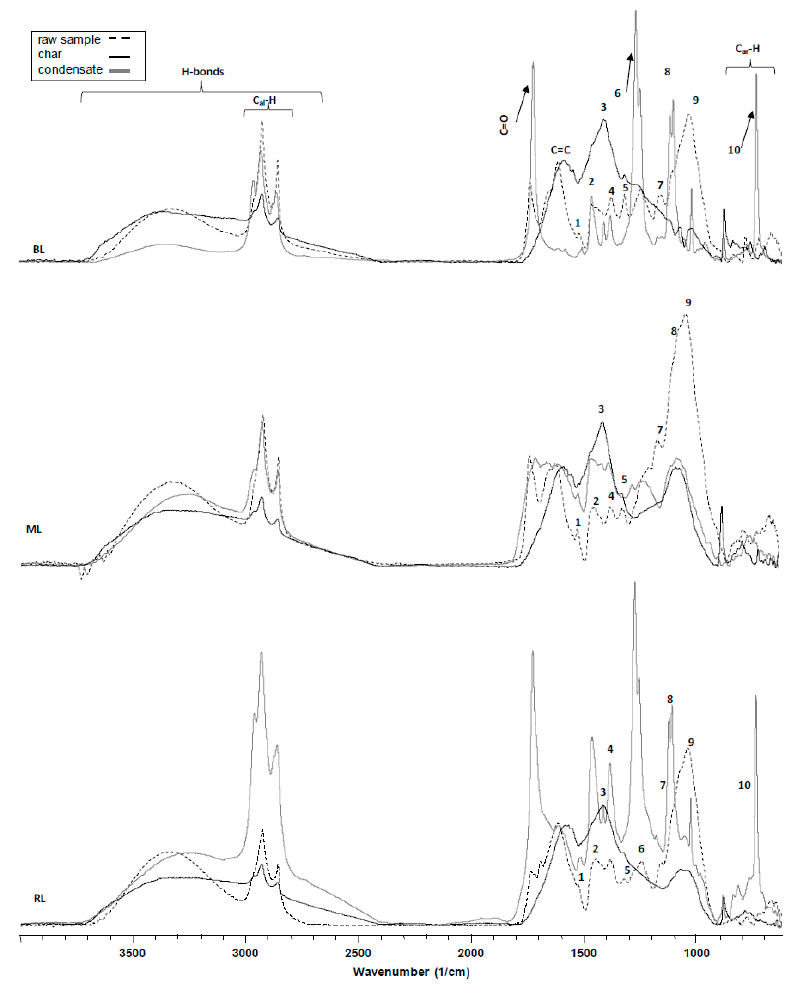
Figure 2. ATR spectra of examined samples and their pyrolysis products—chars and condensates: (1) aromatic skeletal vibrations of guaiacyl rings; (2) pyran ring symmetric scissoring C-H defor- mation, asymmetric in-plane for lignin and hemicellulose; (3) aromatic skeletal vibration combined with C-H in-plane deformation of cellulose; (4) C-H deformation in hemicellulose; (5) C-O vibration in syringil and guaiacyl rings; (6) guaiacyl ring breathing, C-O stretch in lignin, C-O linkage in guaiacyl aromatic methoxyl groups; (7) C-O-C stretching vibration ring skeletal pyranose; (8) C-O stretching in cellulose; (9) C-O stretching in cellulose; (10) C-H out-of-plane glucose ring in cellulose and hemicellulose or 1-2-disubstituted aromatic rings